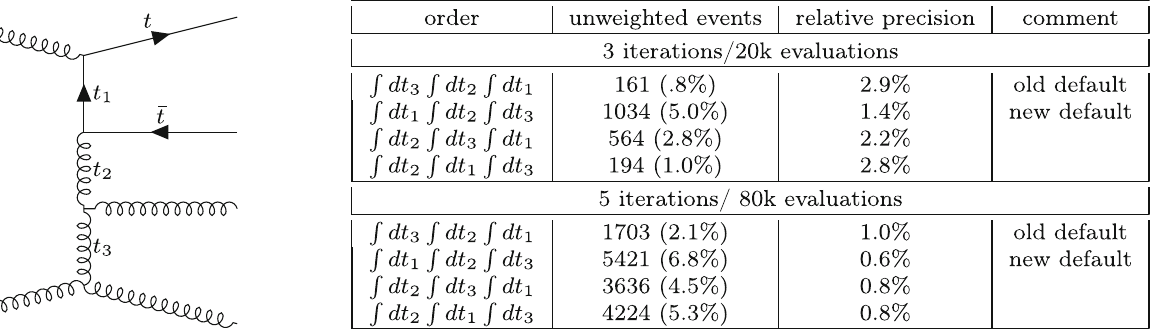
re-scaled accordingly. In such a case the timing is set in bold and the number of events actually generated is then indicated